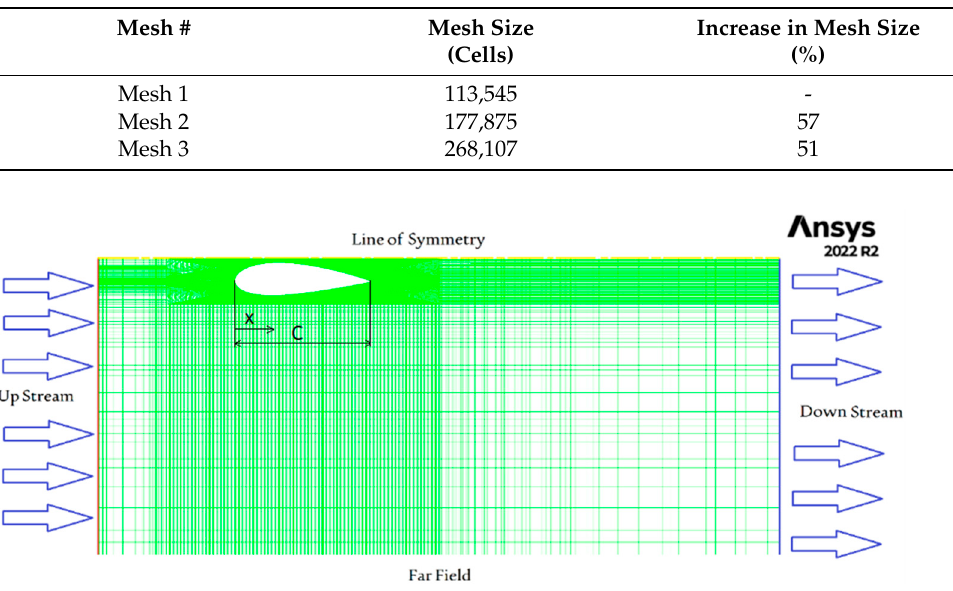
Figure 2. Generated mesh for the CFD solution (268,107 cells).